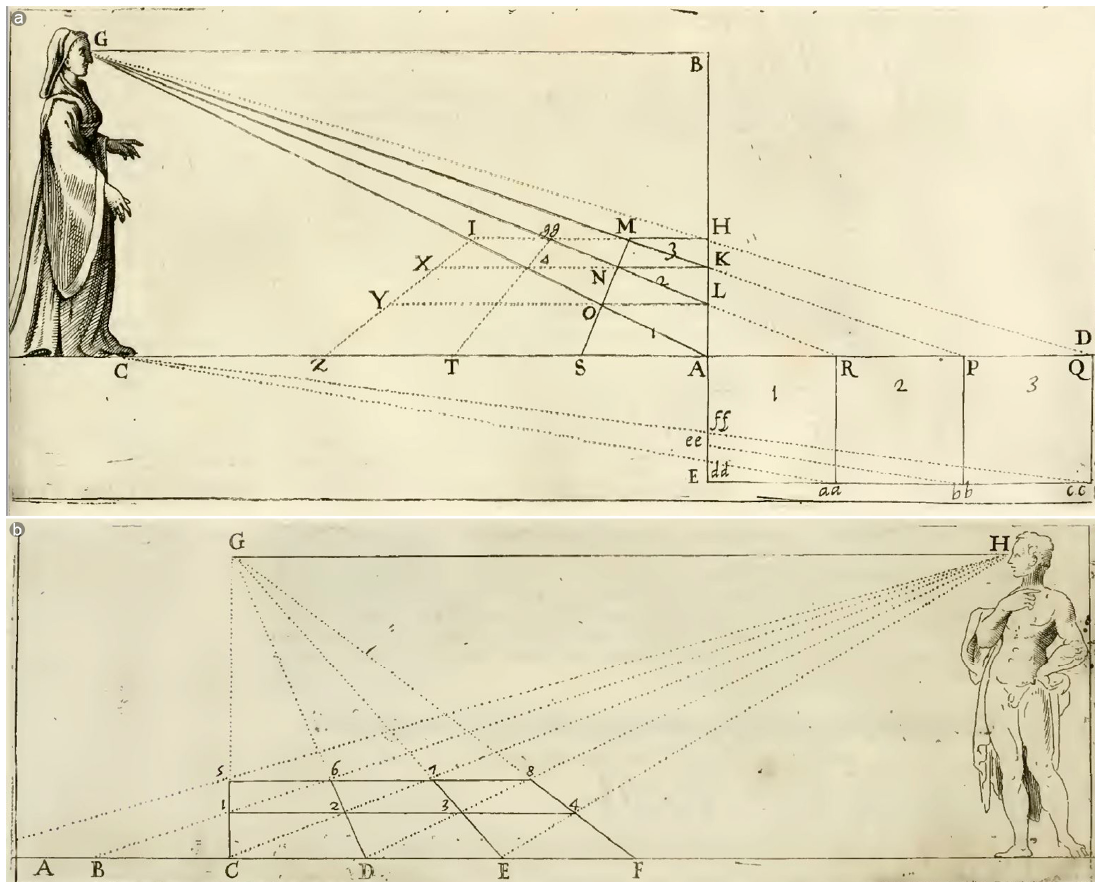
Figure 3. Illustration of the two rules by Vignola. The first ( a ) is located in the sixth chapter of the First rule; the other ( b ) in the second chapter of the Second